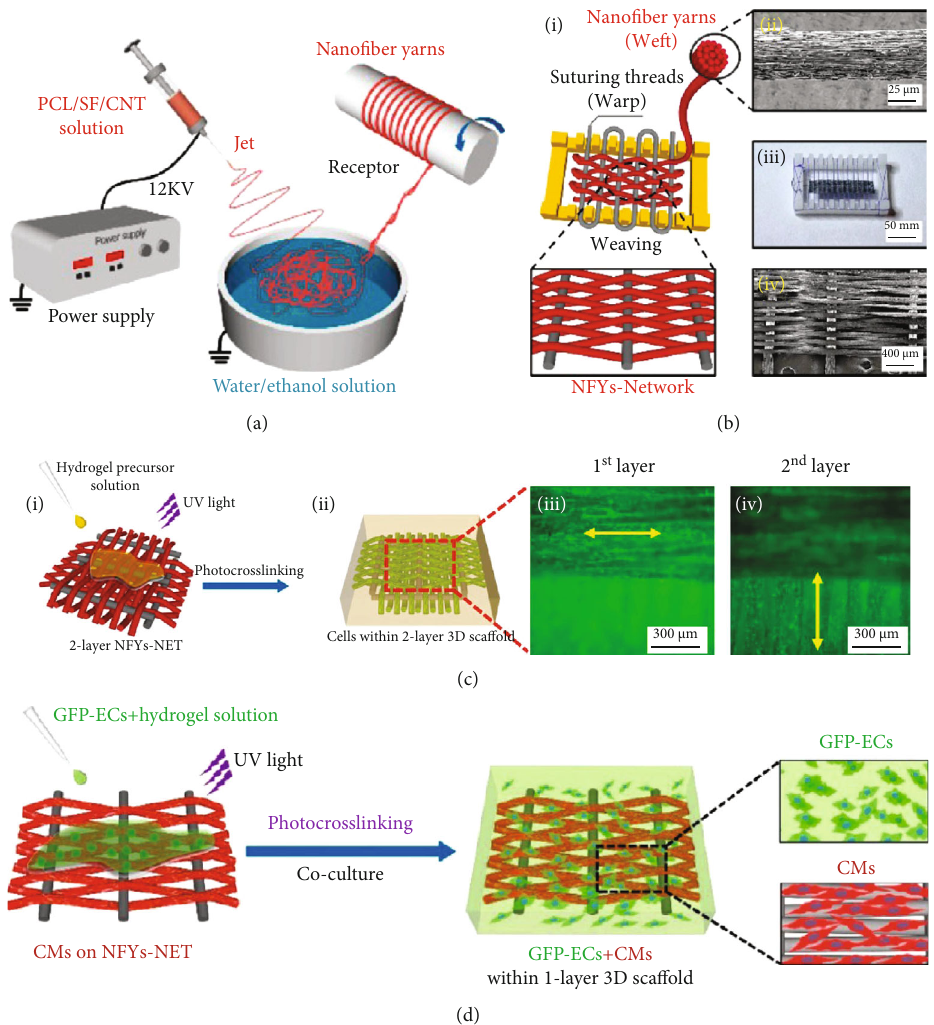
Figure 9: Nano fi ber yarn/hydrogel composite 3D sca ff olds with alignment, conductivity, and anisotropy for cardiac tissue engineering. Schematic illustration of (a) PCL/SF/CNT nano fi ber yarns prepared by wet-dry electrospinning and (b) NFYs-NET sca ff olds fabricated by a weaving technique. (c) 3D composite sca ff old fabricated via encapsulating two layers of NFYs-NET with orthogonal orientation within UV crosslinked GelMA hydrogel (i). F-Actin (green) staining of CMs cultured on the NFYs-NET layer with horizontal direction (iii) and vertical direction (iv) within a 2-layer 3D sca ff old. (d) Coculture of CMs and ECs within yarn/hydrogel 3D composite sca ff olds. CMs were cultured on the NFYs-NET layer while ECs with green fl uorescent protein were encapsulated within a hydrogel shell. Reproduced with permission from [67]. Copyright © 2017, American Chemical